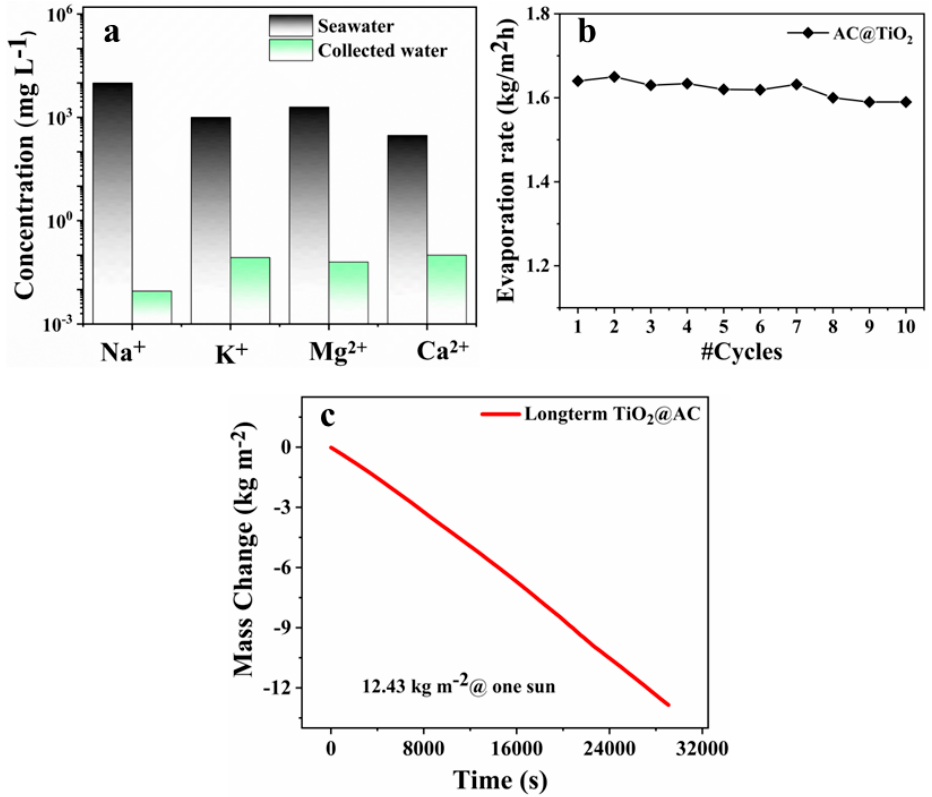
Figure 6. Self-regenerating and salt-resistant performance of in-situ polymerized ISPN solar evaporator. ( a ) Inductively coupled plasma-optical emission spectrometry (ICP-OES) examination of a concentration gradient of primary salt ions in stimulated seawater and condensed water. ( b ) The number of washing cycles vs. evaporation rates of TiO 2 /AC solar evaporator. ( c ) Long-term evaporation performance under one sun solar irradiance.